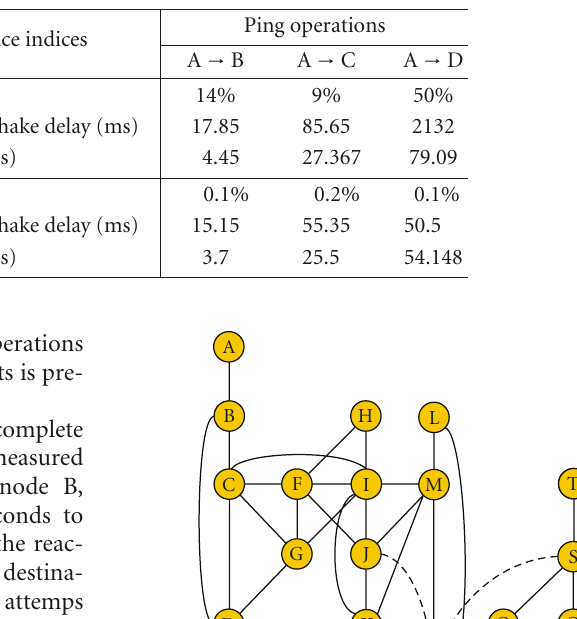
Table 1: Indoor string topology: experimental results.